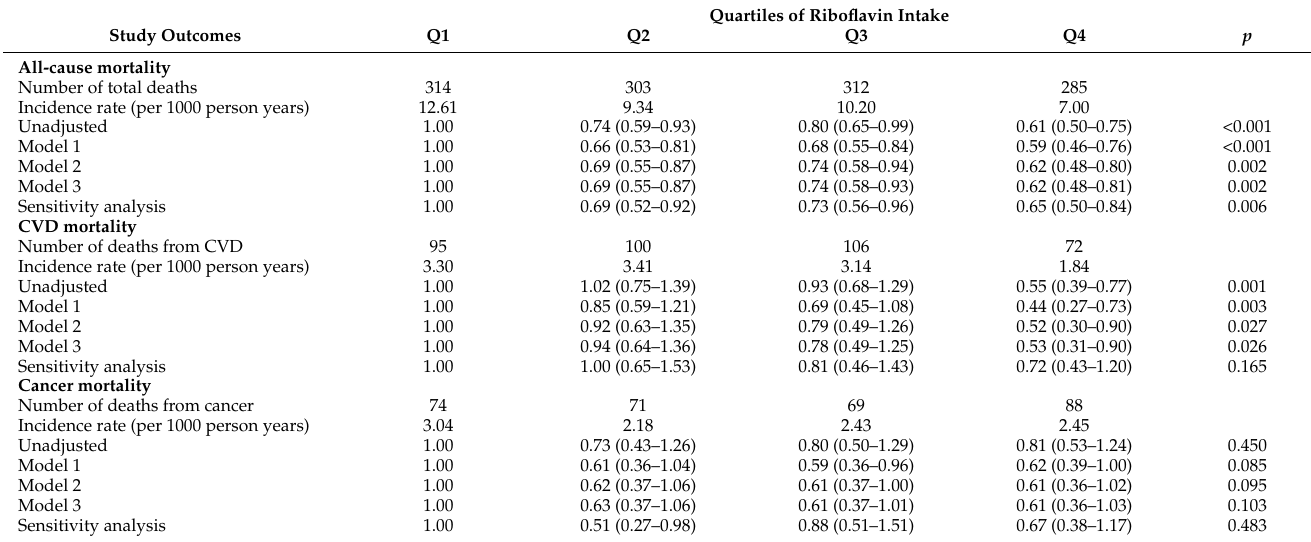
Table 2. Association between riboflavin intake and mortality among adults attending